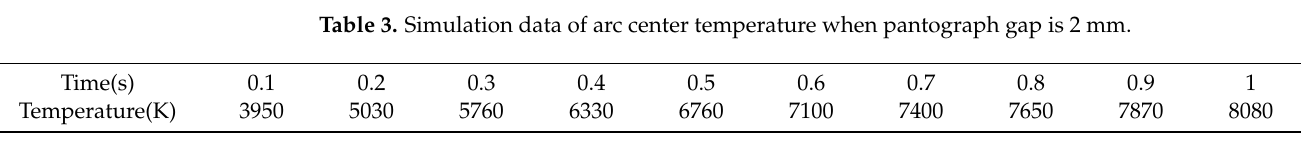
Table 4. Simulation data of arc center temperature when pantograph gap is 3 mm.